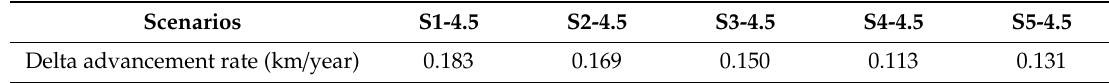
Table 5. Delta advance rate towards the dam face.